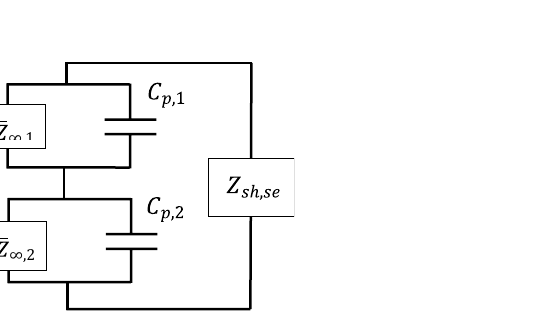
Figure 13. ( a ) The two piezoelectric shunt dampers in a series configuration on thin-plate ( b ) its equivalent electrical circuit representation with shunt circuit, Z sh , se .